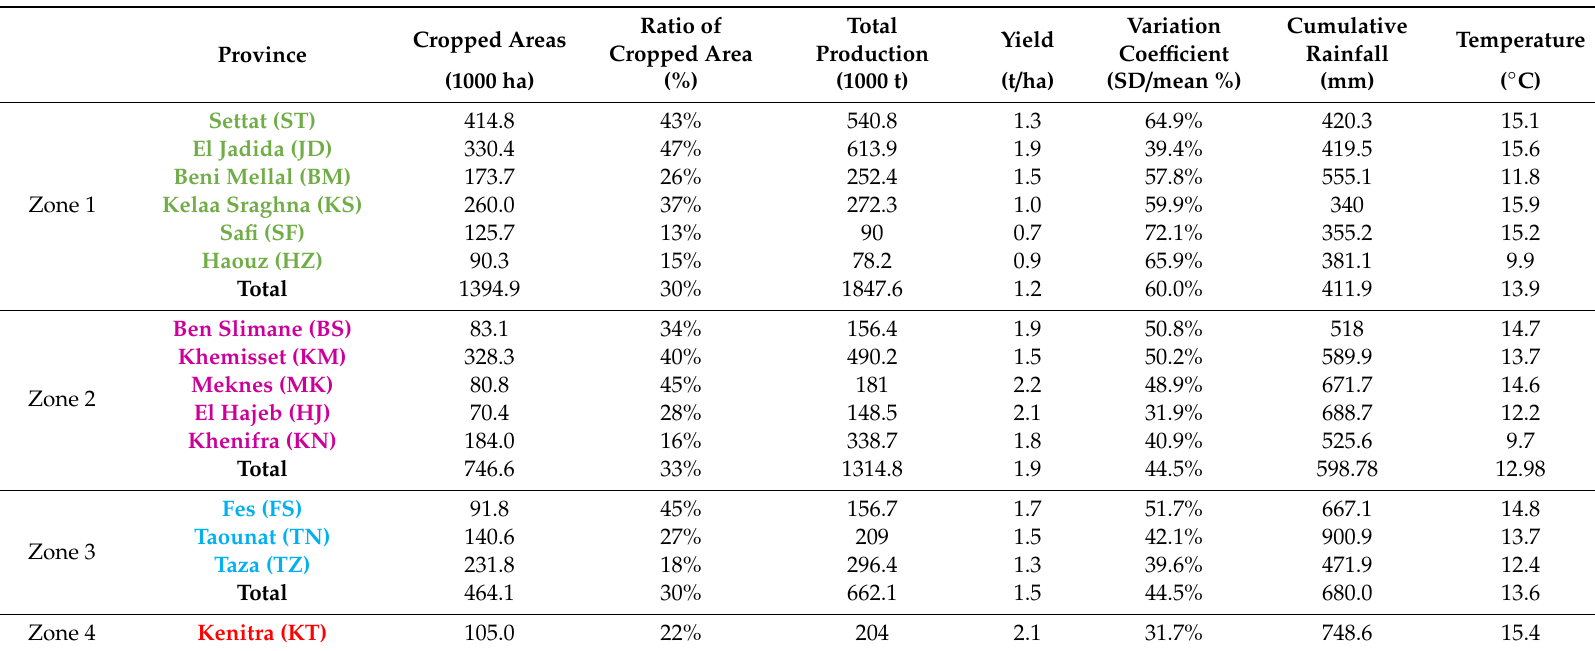
Table 2. Cereal yields and production statistics, average rainfall and air temperature for each province. Colors correspond to the four groups of agricultural provinces (see